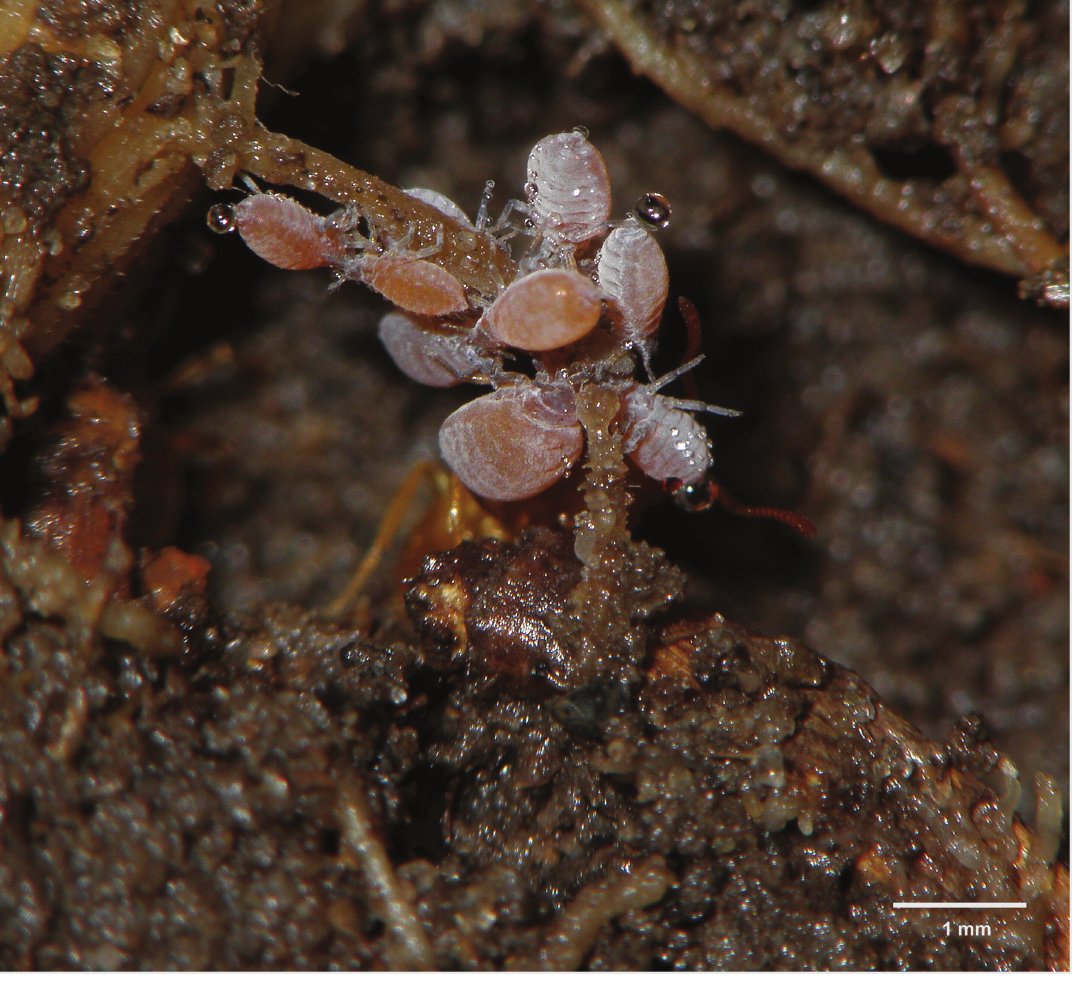
Fi. 16. Tetraneura ulmi (linnaeus, 1758) . Apt. and juv. on grass